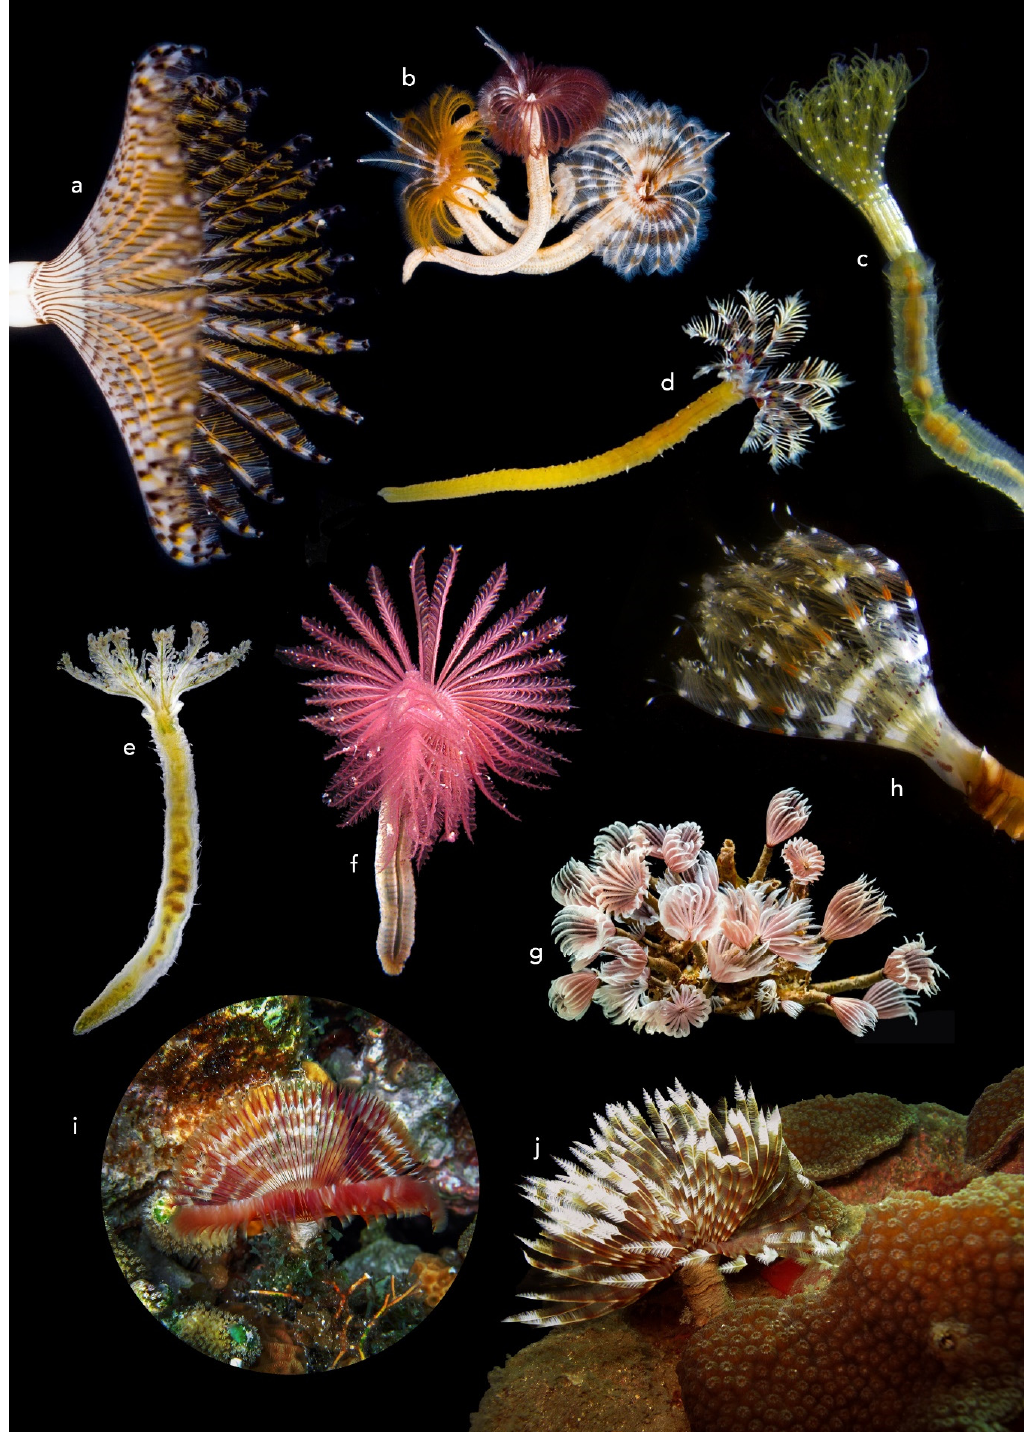
Figure 4. Some sabellid representatives showing a range of the diversity of forms found in the group. ( a ) Stylomma palmatum , Lizard Island, Australia; ( b ) Acromegalomma spp., Lizard Island, Australia; ( c ) Paradialychone ambigua , Lizard Island, Australia; ( d ) Pseudobranchiomma paraemersoni , São Paulo, Brazil; ( e ) Laonome xeprovala, Sea of Azov; (F) Branchiomma sp., Mexico; ( g ) Bispira brunnea , Caribbean; ( h ) Notaulax sp., Lizard Island, Australia; ( i ) Anamobaea orstedii ., Mexico; ( j ) Sabellastarte magnifica , Mexico. ( a , b , g , by M. Bok; e by V. Syomin, i,j by H. Bahena).